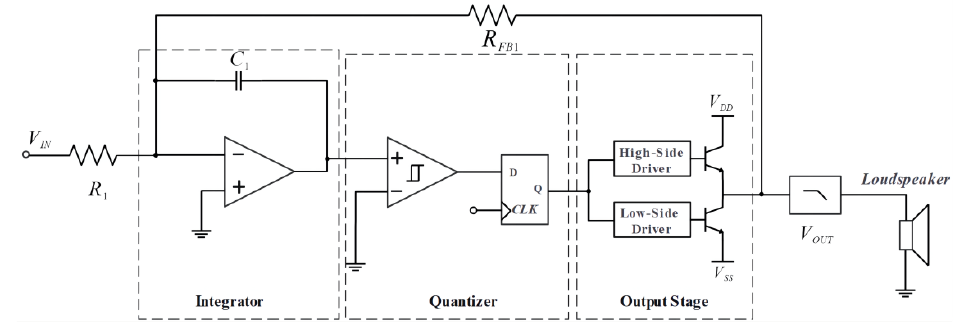
Figure 10. First- order synchronous Δ - Σ Class D amplifier block diagram.